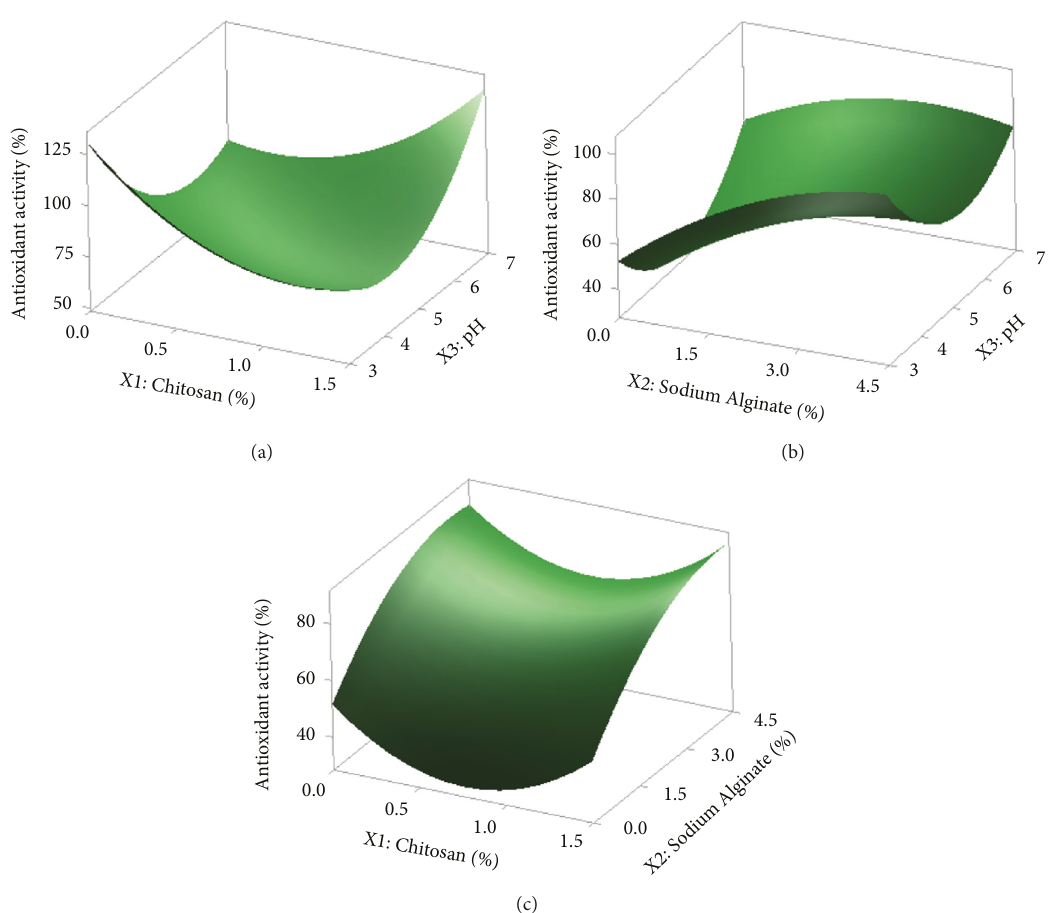
Figure 3: Three-dimensional plot of antioxidant activity of emulsion. (a) Antioxidant activity vs. chitosan concentration. (b) Antioxidant activity vs. sodium alginate concentration. (c) Antioxidant activity vs. chitosan concentration and sodium alginate